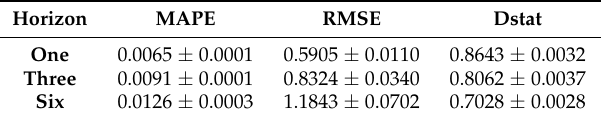
Table 3. Statistical results of running the experiment ten times by the EEMD-APSO-RVM (mean ± std.). Horizon